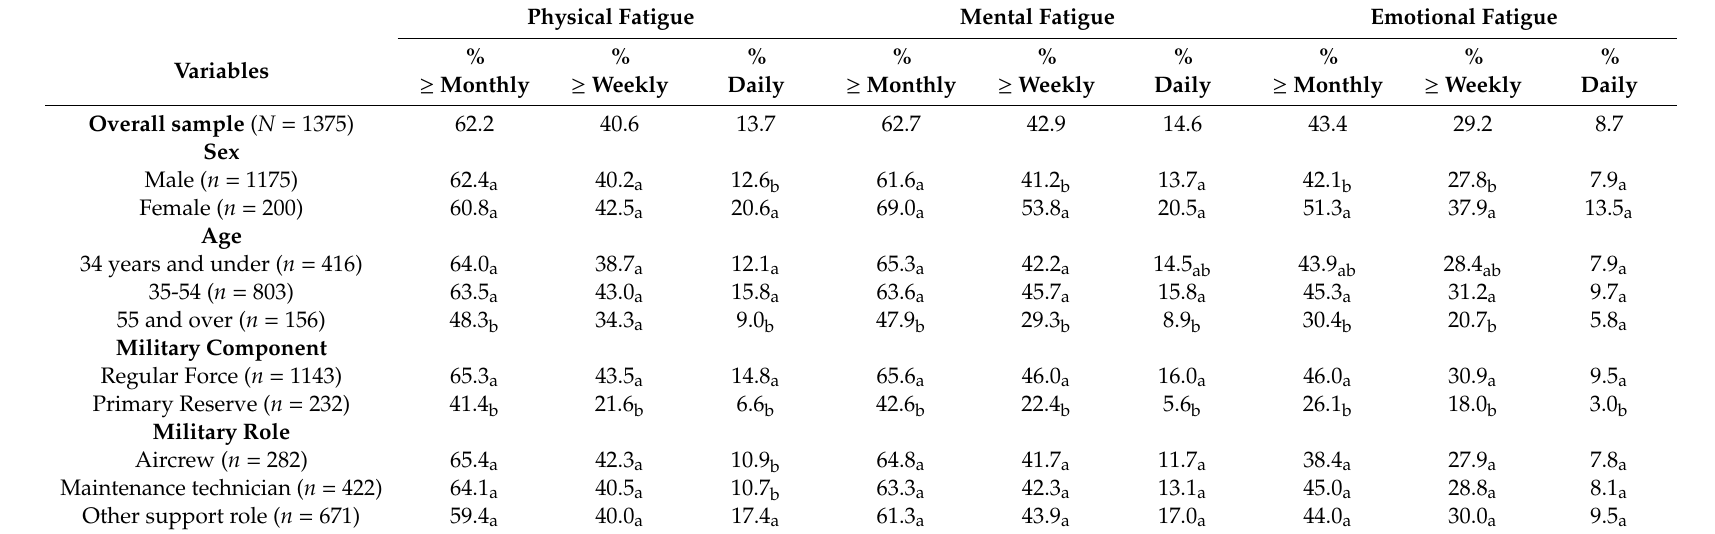
Table 3. Prevalence of Work